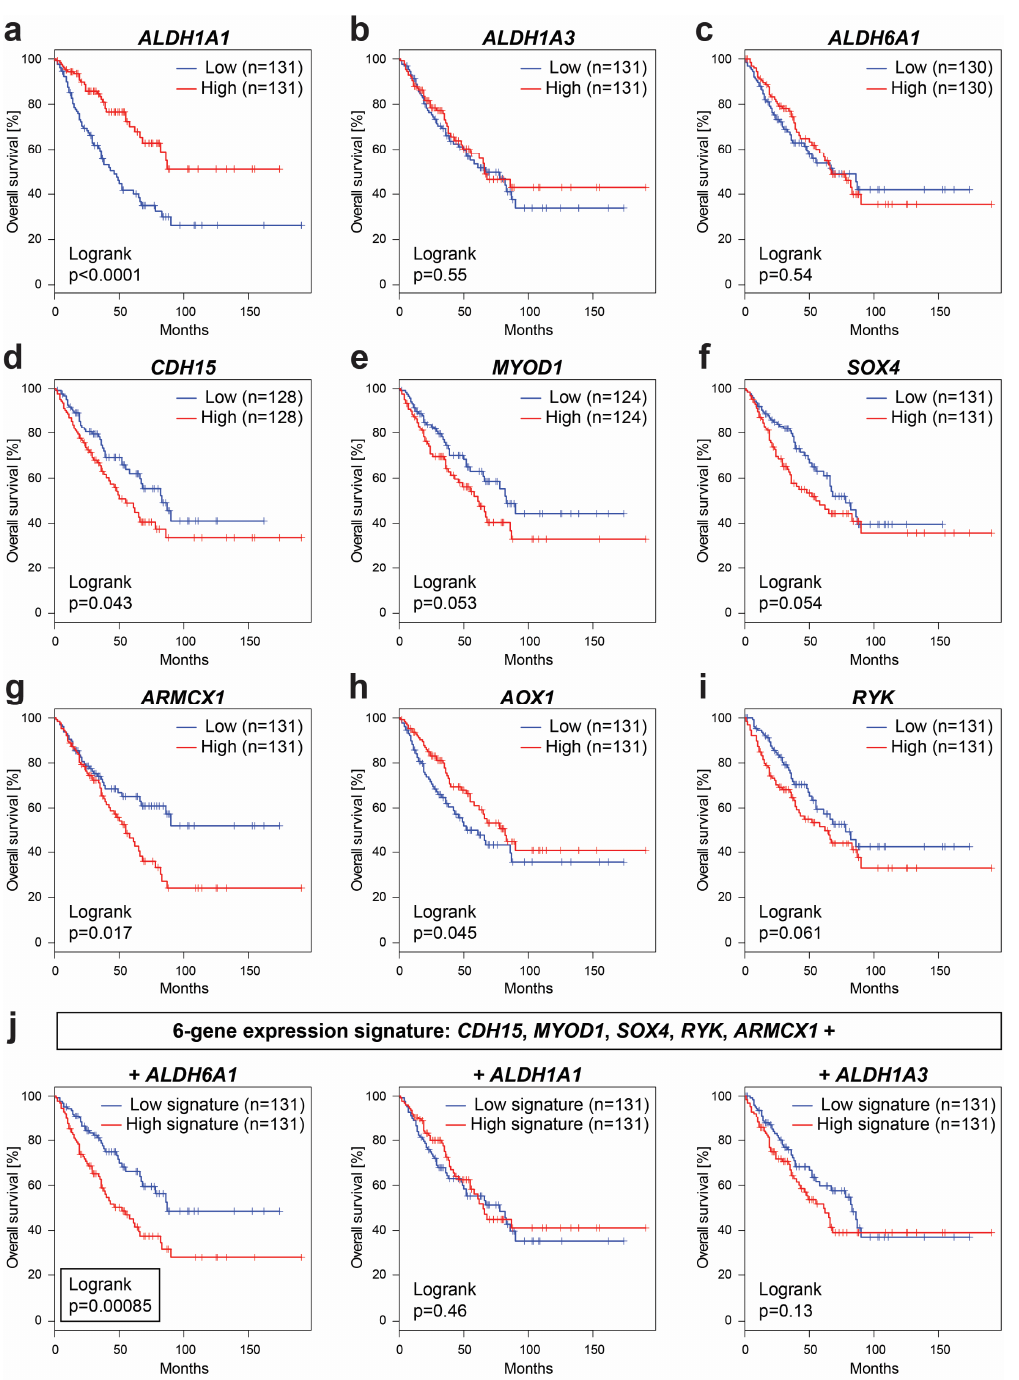
Figure 8. Overall survival in soft-tissue sarcomas (The Cancer Genome Atlas Sarcoma (TCGA-SARC) dataset) based on the gene expression levels of ( a ) ALDH1A1 , ( b ) ALDH1A3 , ( c ) ALDH6A1 , ( d ) CDH15 , ( e ) MYOD1 , ( f ) SOX4 , ( g ) ARMCX1 , ( h ) AOX1 , and ( i ) RYK . ( j ) Significant prognostic value of 6-gene expression signature comprising ALDH6A1 ( left ) but not ALDH1A1 ( middle ) and ALDH1A3 gene ( right ). The analysis was performed using the GEPIA 2 online tool [32].